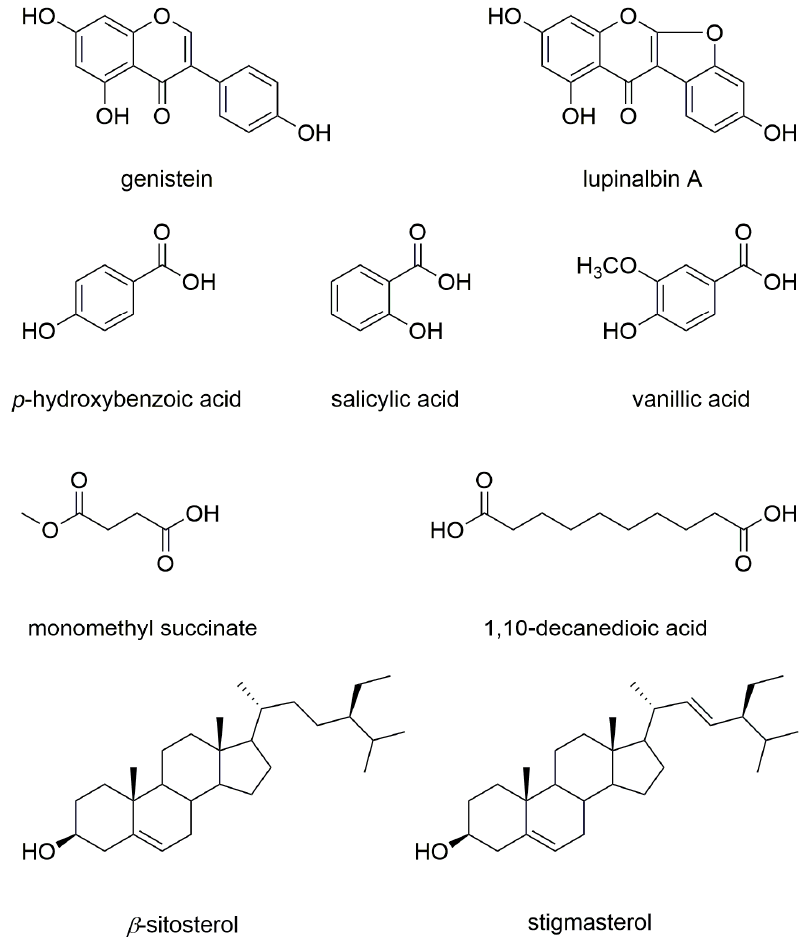
Figure 5. Chemical structures of the compounds identified in this study.